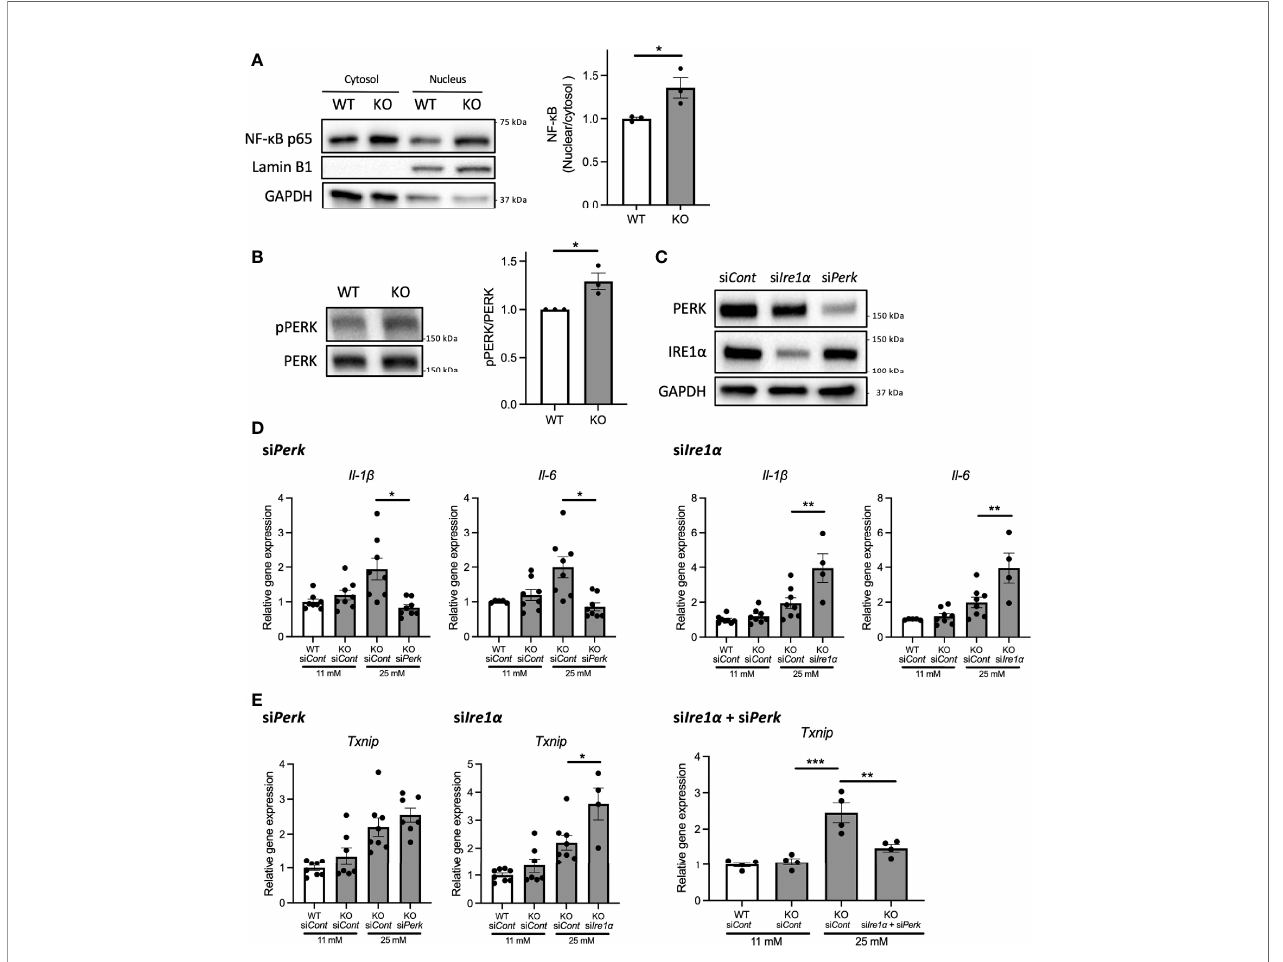
FIGURE 4 | PERK pathway regulates the high-glucose induced pro-in fl ammatory gene expression in Wfs1 -de fi cient pancreatic b -cells. (A) Left panel: Immunoblot images of NF- k B p-65 in the cytosolic or nuclear fraction of Wfs1 wild-type (WT) and knockout (KO) INS-1 832/13 cells. WT and KO INS-1 832/13 cells were treated with 5 mM glucose for 18 h and then with 25 mM glucose for 30 min. Right panel: The ratio of nuclear and cytosolic NF- k B p-65 protein levels (n=3). (B) Left panel: Immunoblot images of pPERK and PERK. WT and KO INS-1 832/13 cells were treated with 5 mM for 16 h and then with 25 mM glucose for 24 h. Right panel: pPERK band intensity was quanti fi ed and normalized to total PERK (n=3). (C) Immunoblot images of PERK and IRE1 a in WT and KO INS-1 832/13 cells treated with siRNA against Perk or Ire1 a . (D) mRNA expression level of Il-1 b and Il-6 normalized to 18srRNA in WT or KO INS-1 832/13 cells treated with 11 mM or 25 mM glucose for 30 h together with siRNA against Perk or Ire1 a (n=4-8) (E) mRNA expression levels of Txnip normalized to 18srRNA in WT and KO INS-1 832/13 cells treated with 11 mM or 25 mM glucose for 6 h together with siRNA against Ire1 a and Perk (n=4). Data are shown in mean ± SEM, *P < 0.05, **P < 0.005, ***P <